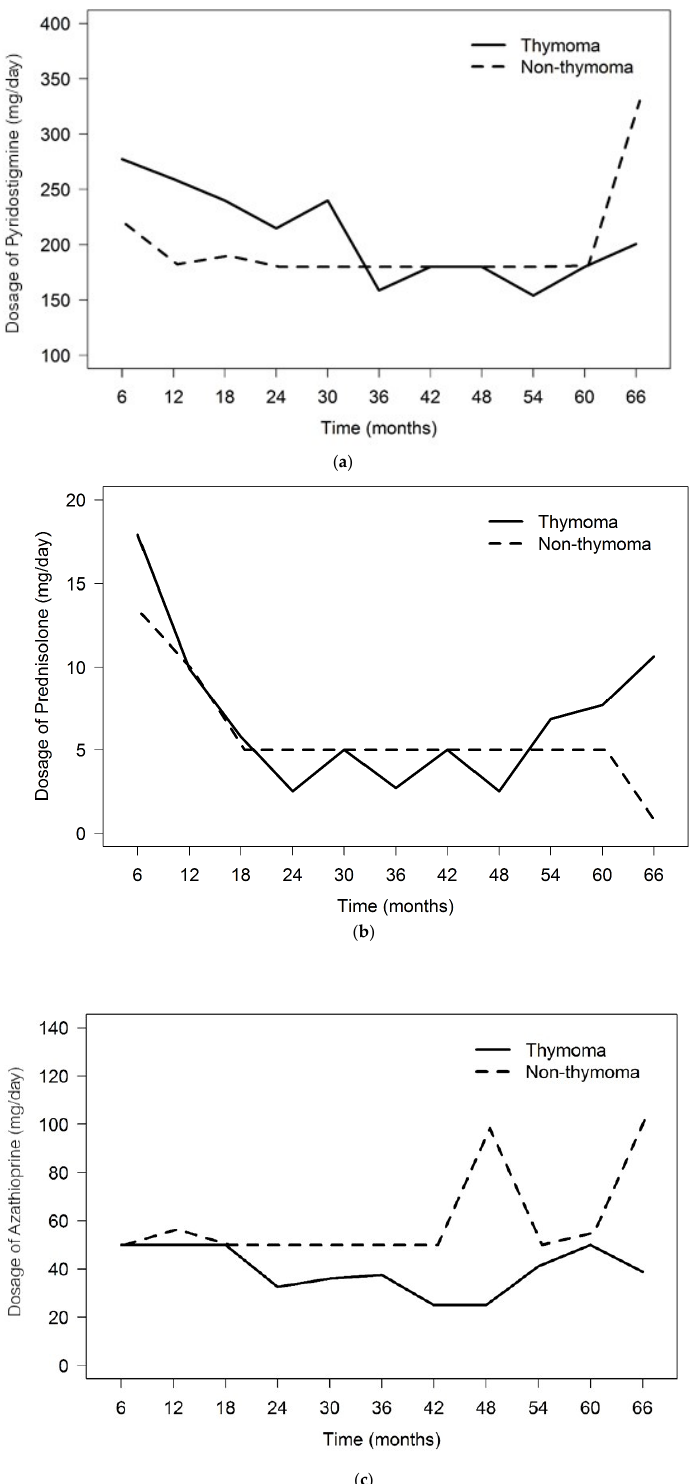
Figure 1. Illustrations demonstrating the time-weighted averages (TWAs) of individual MG treatment drug dosages required during the follow-ups: ( a ) pyridostigmine (Mestinon R ); ( b ) prednisolone; ( c ) azathioprine. After the thymectomies, the patients were followed at the OPD with variable lengths of time intervals, as mentioned earlier. MG-PISs were conducted yearly at the last follow-